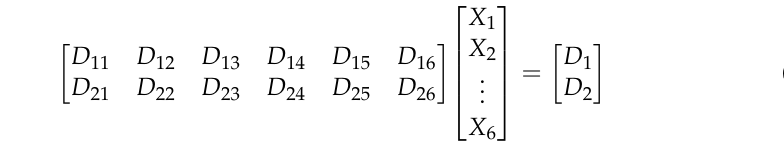
Table 7. Number of cycles for each test condition in fatigue aging failure mode. Condition Speed (rpm) Temperature (°C)